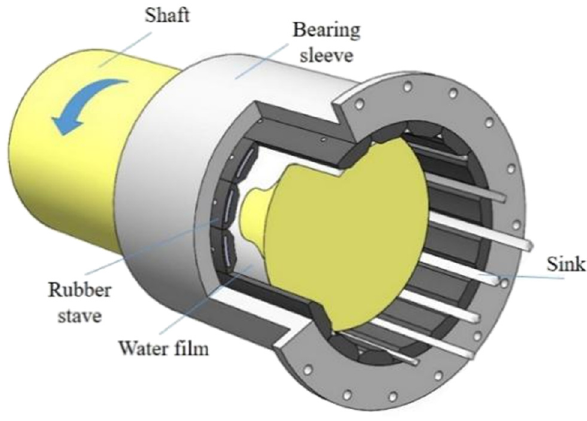
Figure 1: Schematic diagram of a water - lubricated